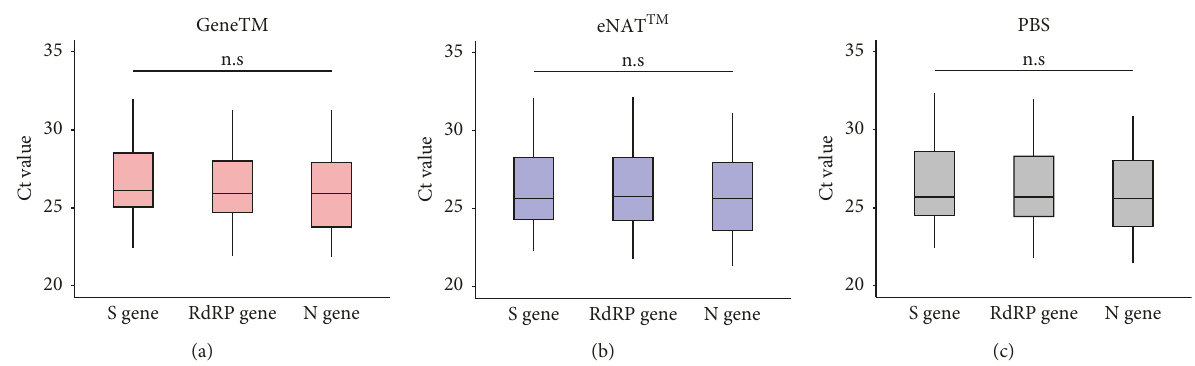
Figure 2: Distribution of Ct values for matched SARS-CoV-2-positive NPS samples and the three SARS-CoV-2 genes S, RdRP, and N in the three transport media. (a) GeneTM. (b) eNAT ™ . (c) PBS. Two replicates per sample were assayed using real-time PCR under the indicated conditions. PBS, phosphate-buffered saline; Ct, cycle threshold; S gene, spike gene; RdRP gene, RNA-dependent RNA polymerase gene; N gene, nucleocapsid gene; n.s., not significant.